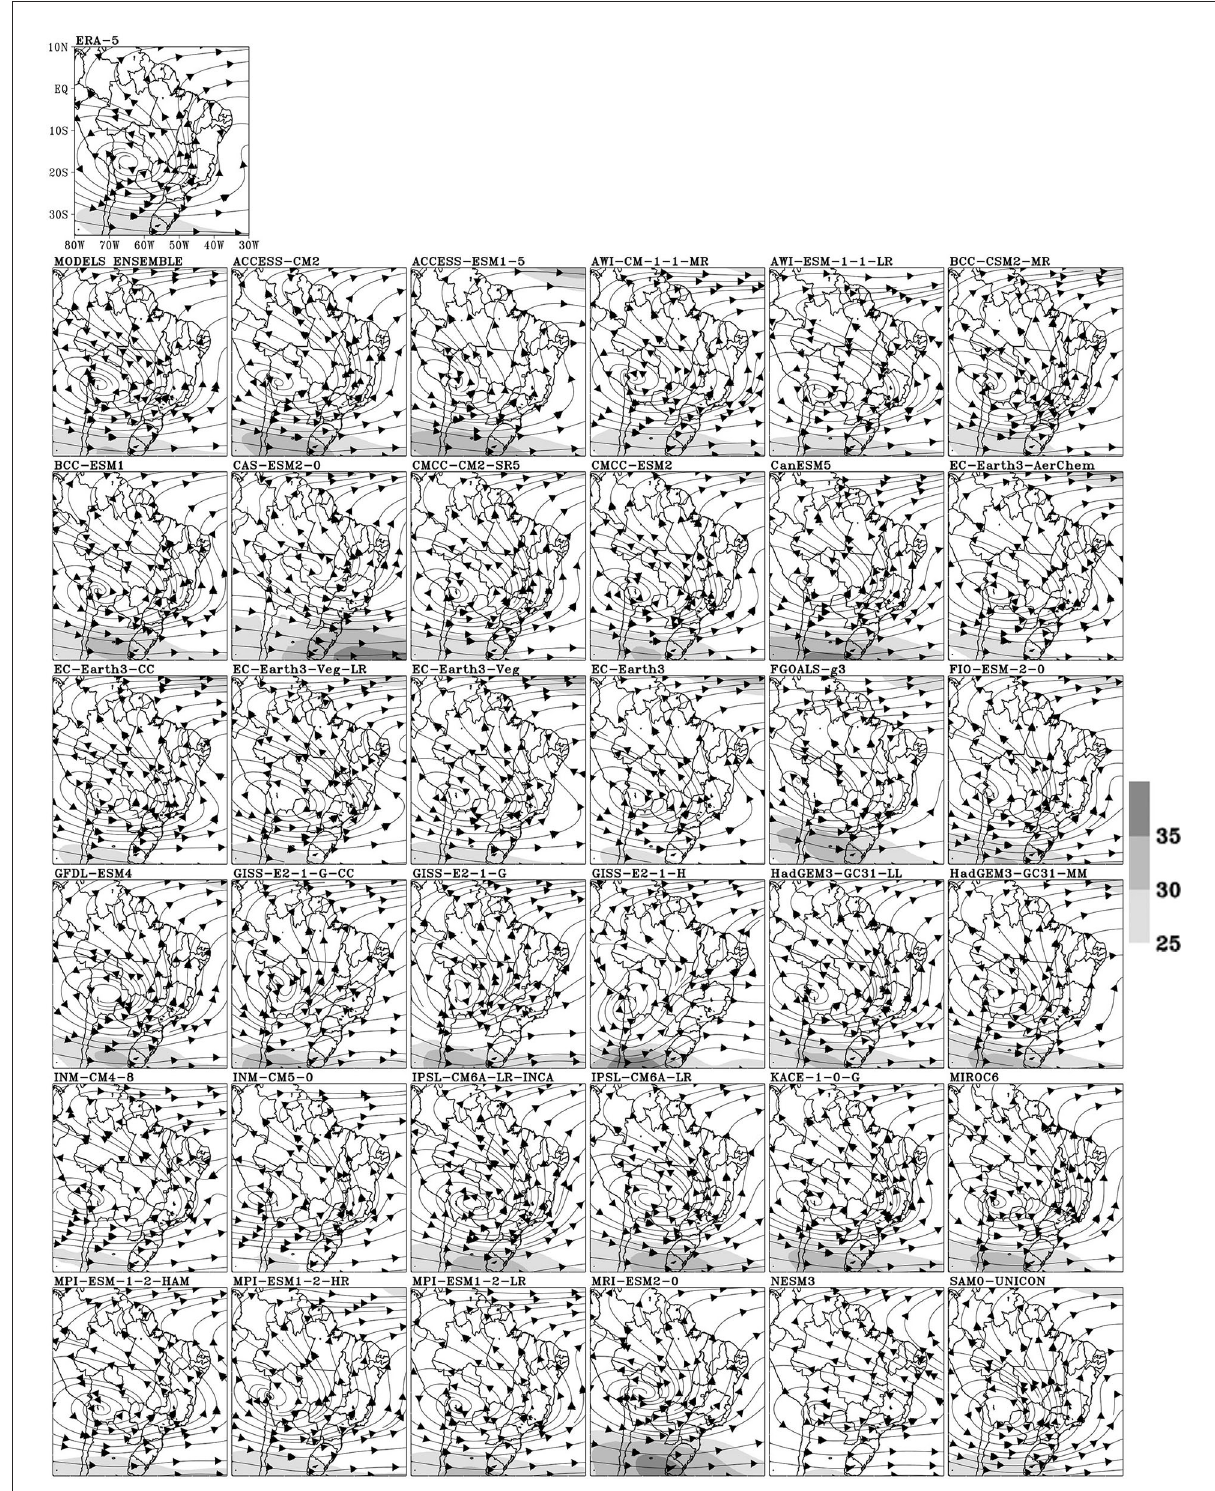
FIGURE4 Streamlines and magnitude of climatological winds (m/s) at 200 hPa simulated by the multi-model ensemble mean, individual CMIP6 models, and ERA-5 reanalysis (top left) for austral summer (DJF) during the historical period. The shaded regions represent wind magnitude starting from 5 m/s while the vector shows the wind